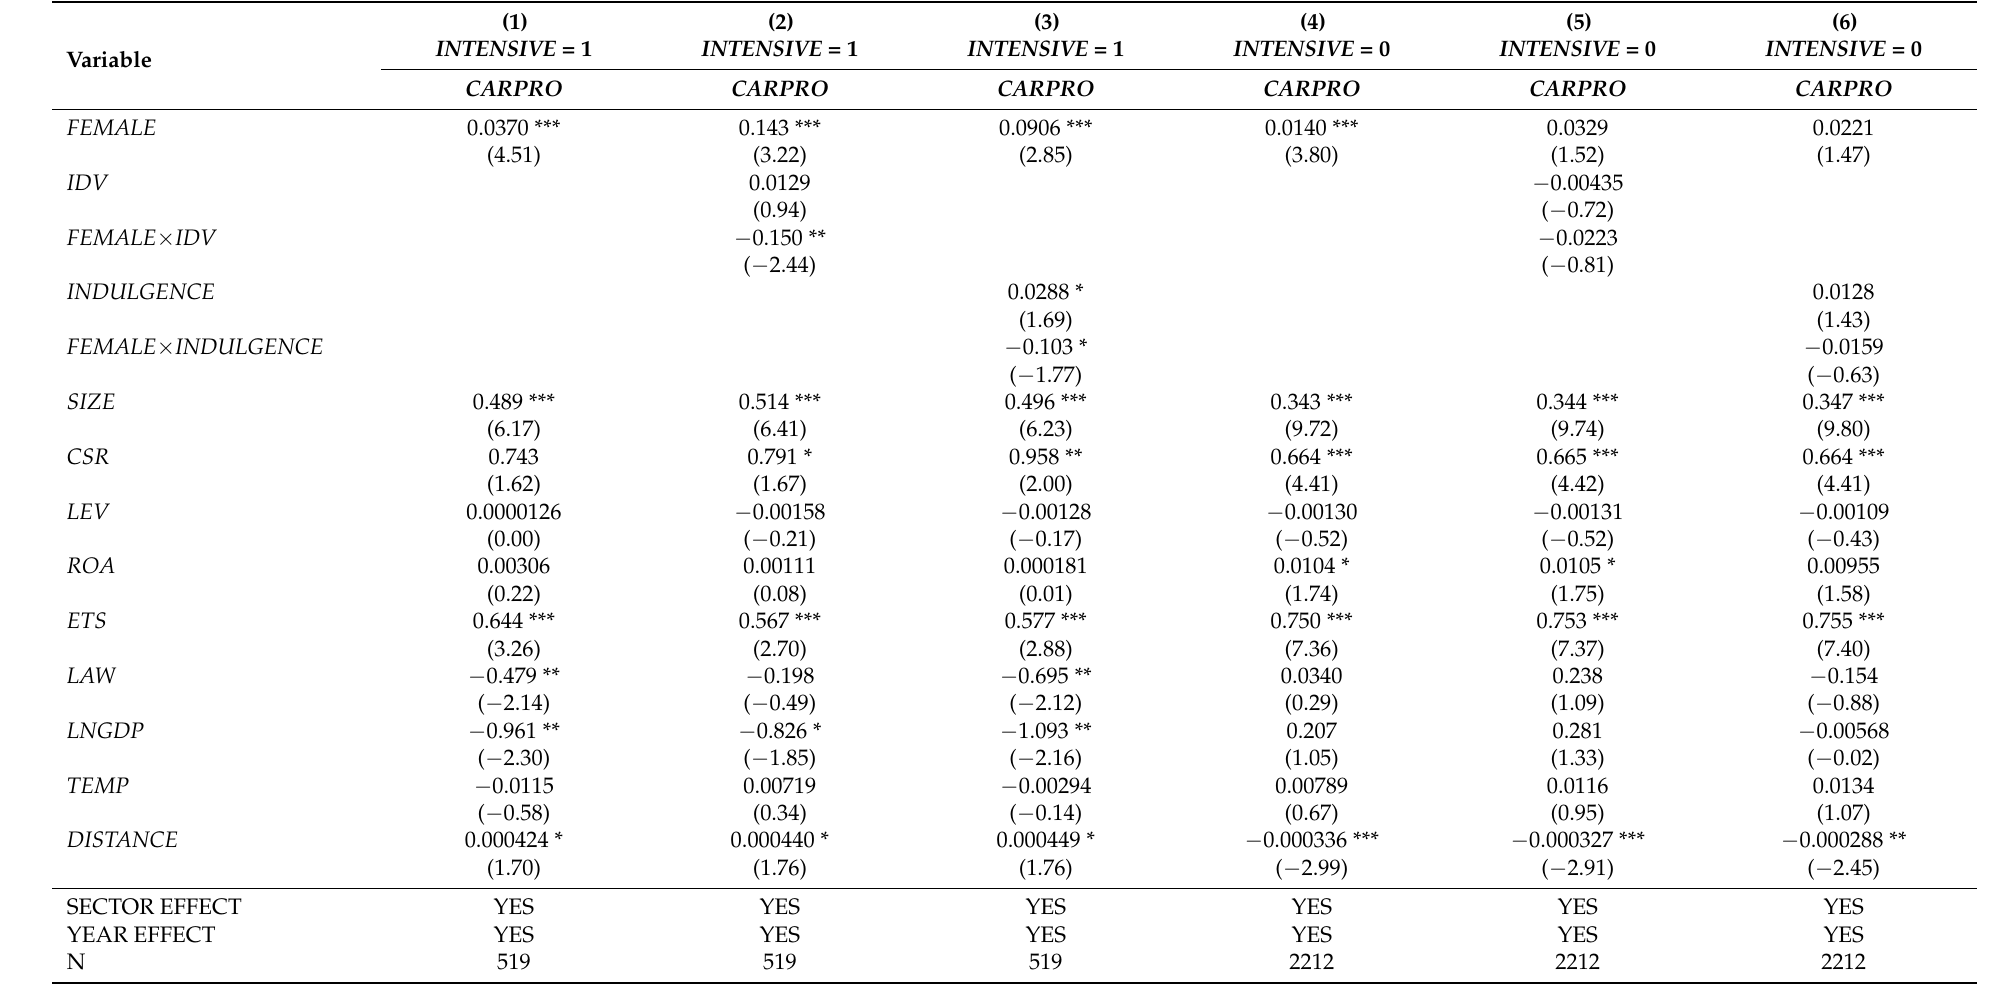
Table 7. Results of subsample analyses based on membership in a carbon-intensive